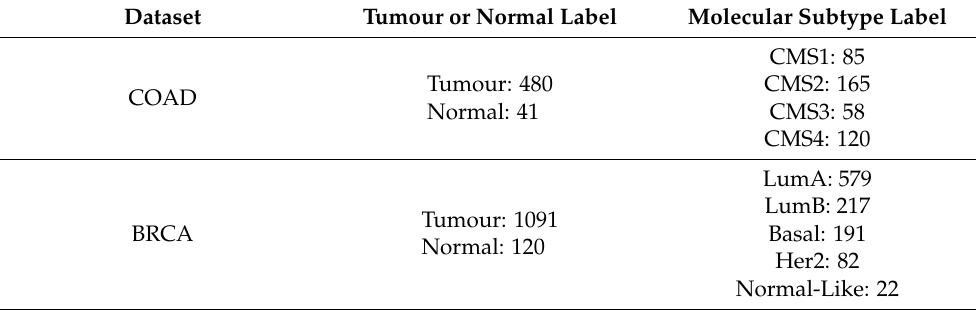
Table 1. TCGA dataset